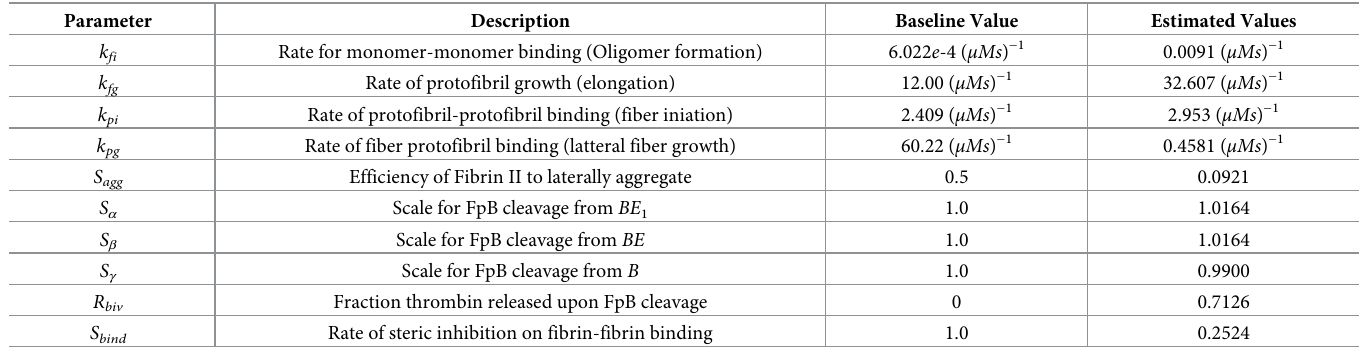
Table 2. Parameters for the polymerization